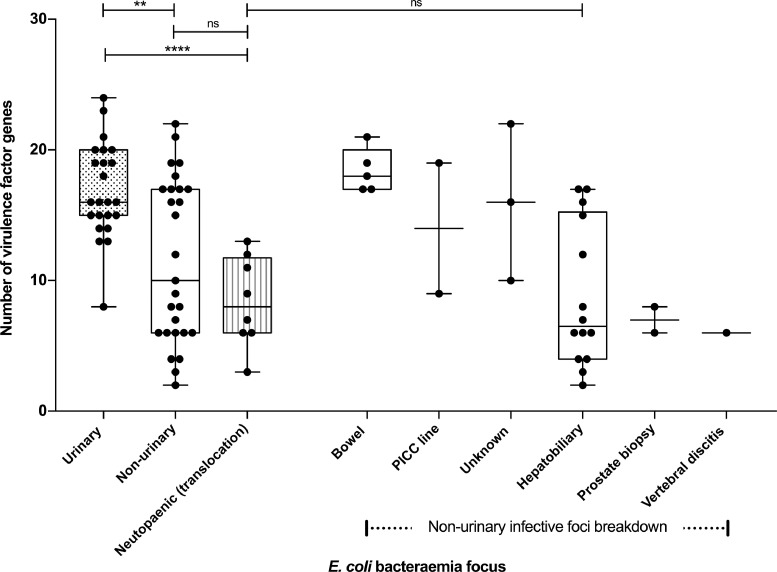
Number of virulence factor genes amongst E. coli isolates from immunocompetent and neutropaenic patients according to infective focus. Box and whisker plots indicate number of virulence factor genes amongst isolates derived from specific infective foci. Isolates derived from non-urinary foci subdivided further into sub-groups as indicated. Number of virulence factor genes between groups compared with Mann–Whitney test (**p < 0.01; ****p < 0.0001; ns – non-significant). PICC (peripherally-inserted central catheter).